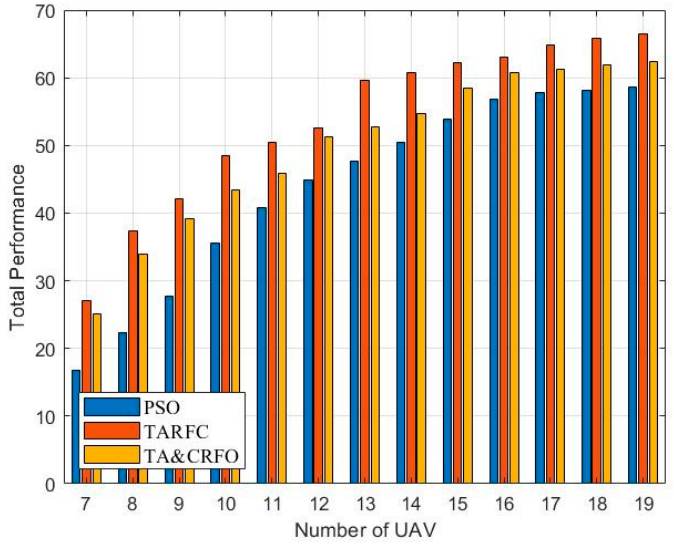
Figure 10. Total Performance of algorithms.